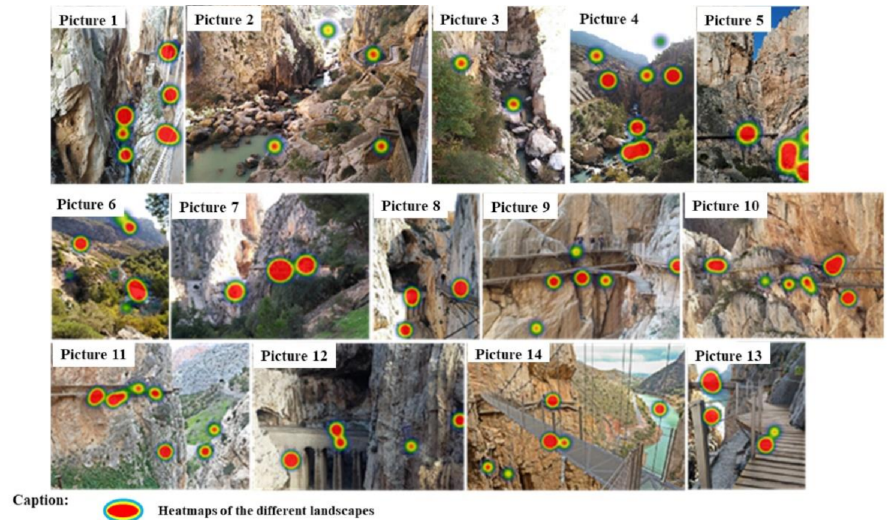
Figure 7. Heat maps of the different landscapes according to